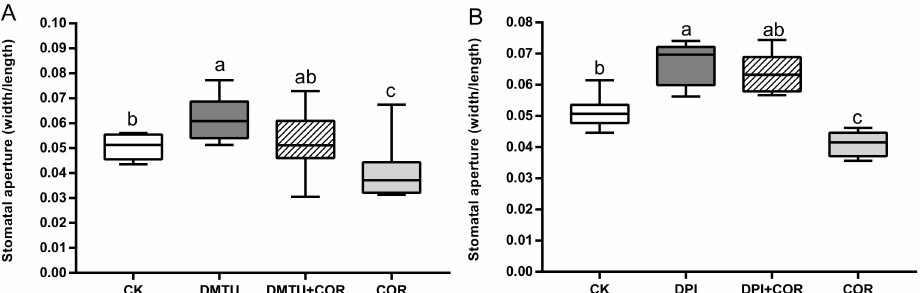
Figure 7. Effect of COR on the stomatal aperture in maize leaves treated with DMTU ( A ) and DPI ( B ). The experiments were repeated three times with similar results. Values are means ± standard error ( n = 10), and different letters indicate significant differences ( p < 0.05) among the